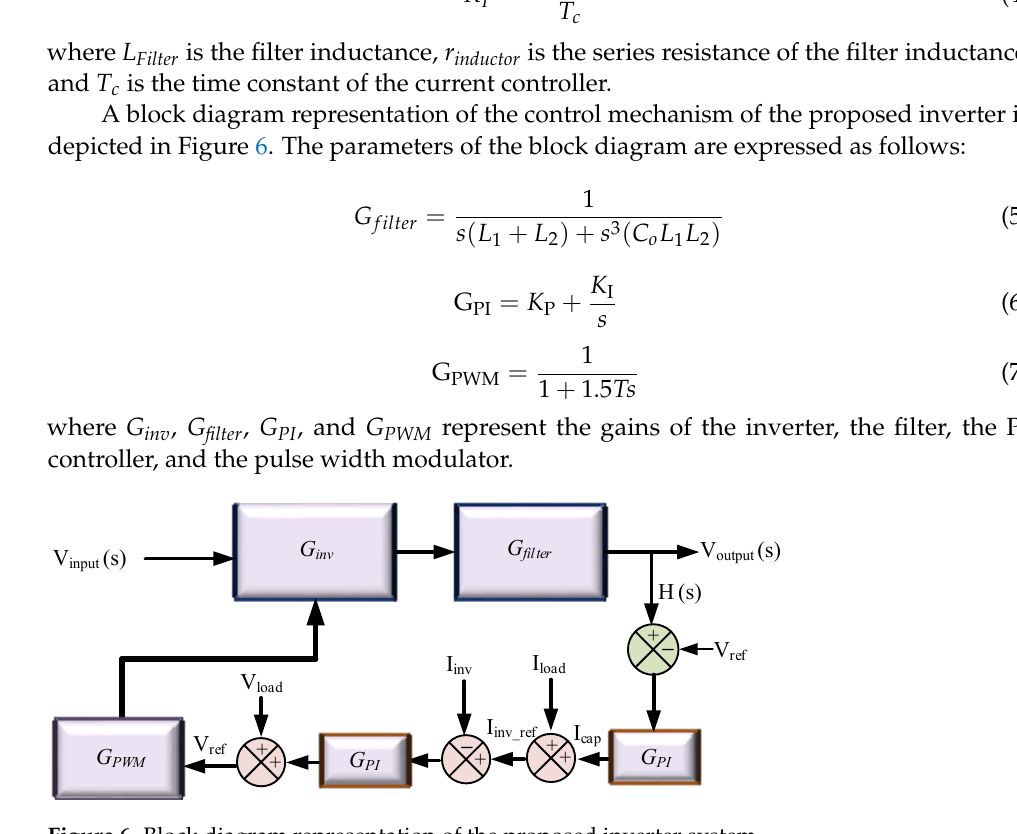
V g C o C PV1 C PV2 Figure 7. C onduction modes under unity power factor: ( a ) positive half-cycle active mode, ( b ) positive half-cycle freewheeling mode, ( c ) negative half-cycle active mode, and ( d ) negative half-cycle freewheeling mode.